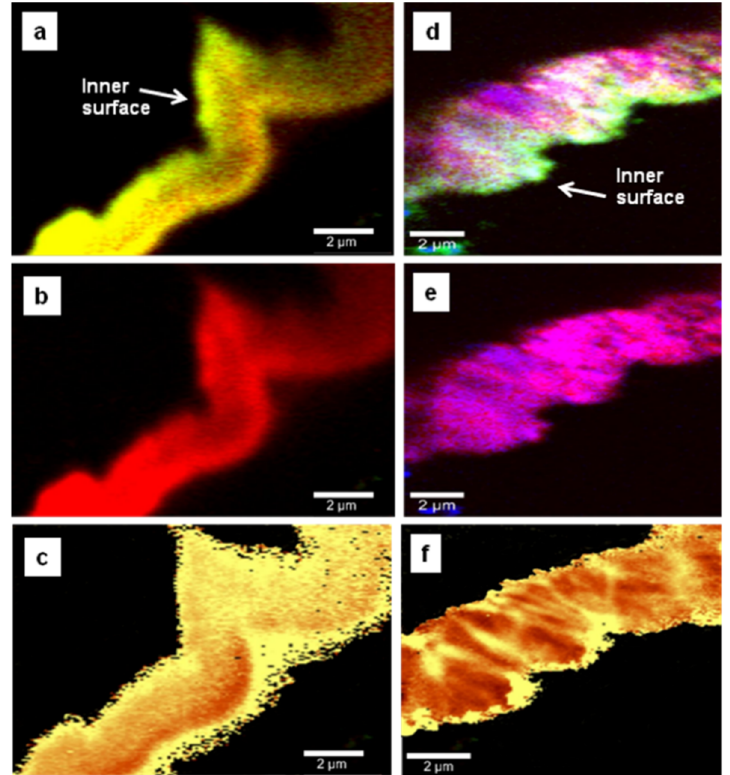
Figure 4. Side-wall confocal Raman images of undoped diamond thin film mapping the spatial distribution of ( a ) diamond (red) and sp 2 carbon (green), ( b ) diamond only, and ( c ) induced stress. Side-wall confocal Raman images of lightly boron-doped thin film showing: ( d ) all the material constituents, ( e ) diamond and boron incorporation, and ( f ) induced stress. Red, blue, and green pseudo-colors are used in image ( d ) for diamond, boron, and carbon impurities, respectively. While in image ( a ) yellow originates from superposition of red and green, in the stress images ( c ) and ( f ), bright yellow and brown correspond to higher or lower induced stress,